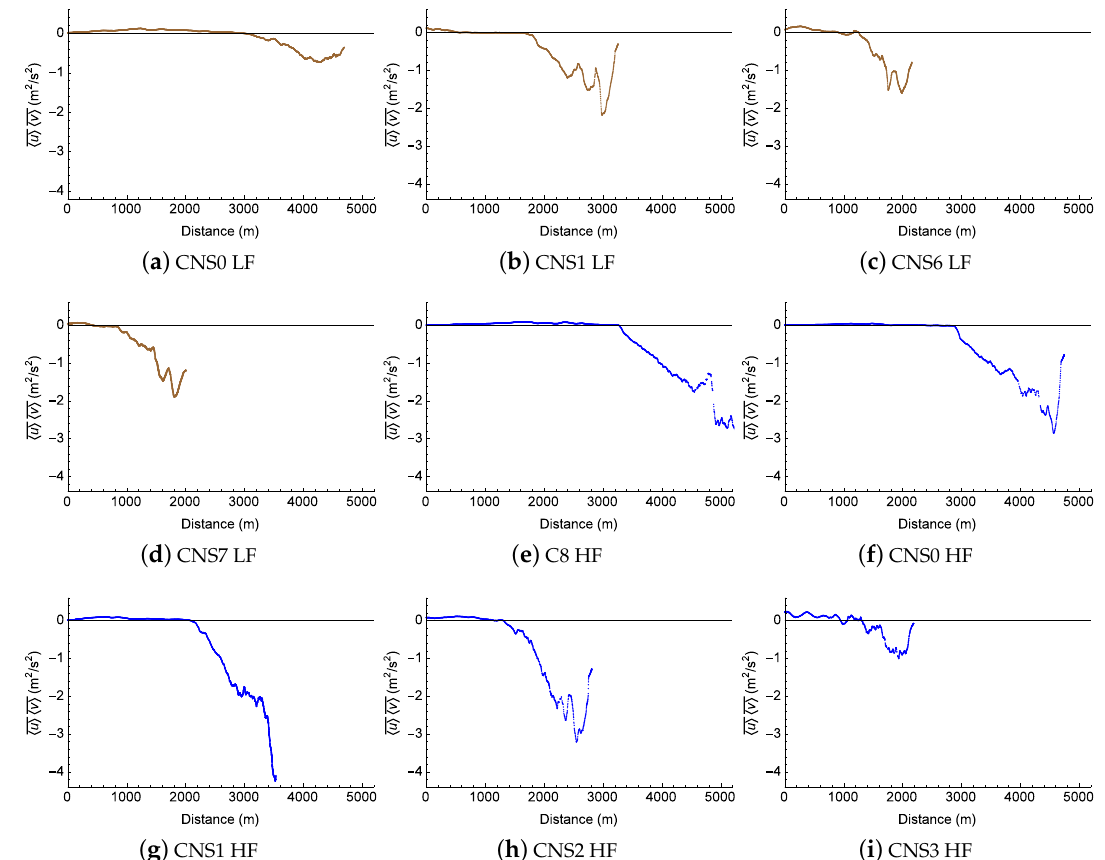
Figure 5. Profiles of the momentum flux by the depth- and length-averaged flow (cid:104) u (cid:105) (cid:104) v (cid:105) across the sampling transects. The brown and blue plots correspond to relatively low and high flow conditions,